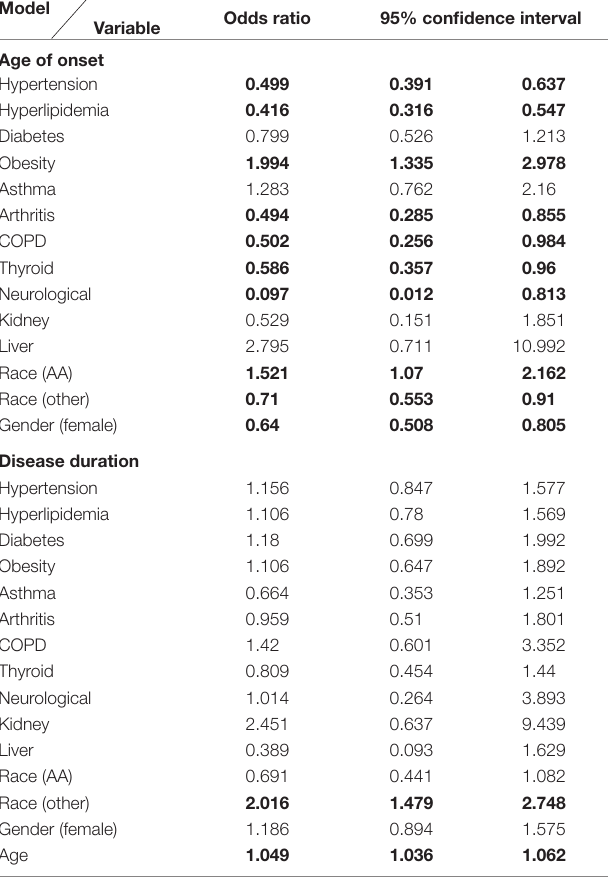
TaBle 4 | Ordinal logistic regression modeling of als age of onset and disease duration.